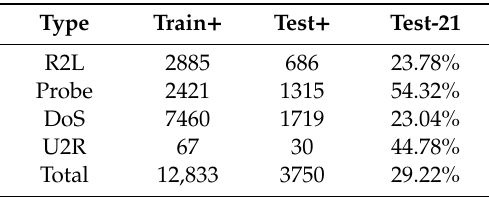
Table 2. NSL-KDD Test + dataset comparison.